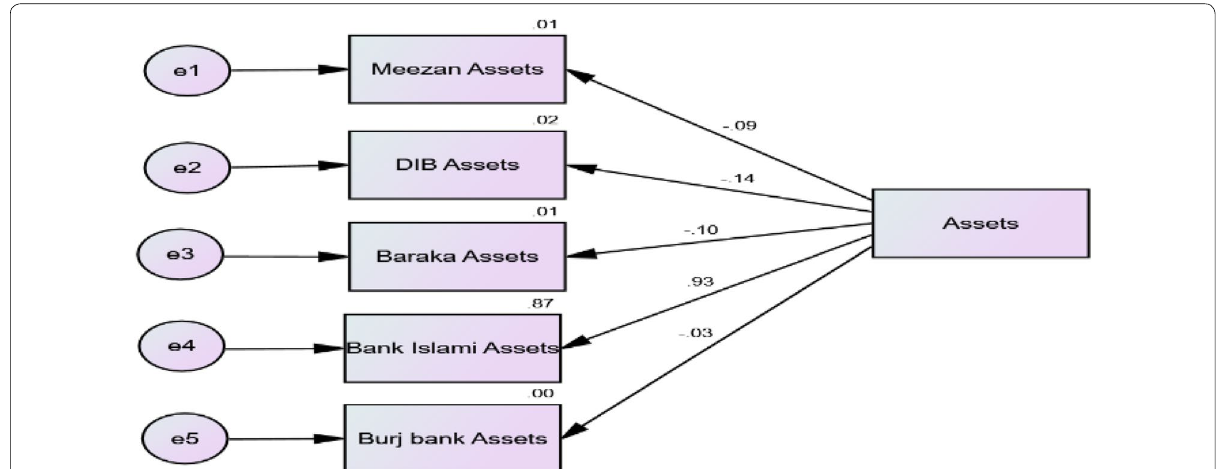
Fig. 3 Islamic banks of Pakistan. The path terms used in the above diagram are: Meezan assets Bank Pakistan Limited; Baraka assets Bank Limited